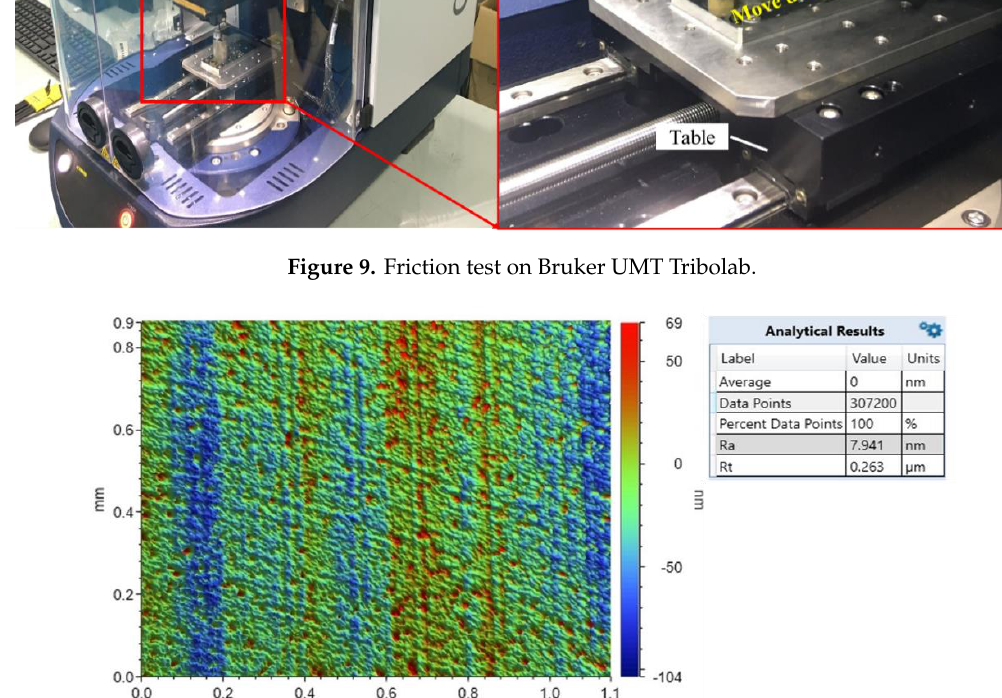
Figure 10. Surface quality evaluation result for the polished Al6061 samples.